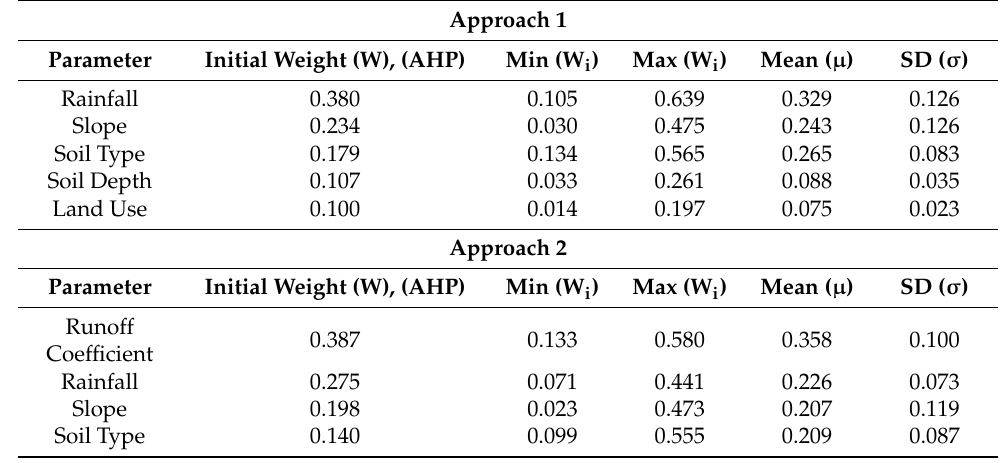
Figure 5. Potential RWH map of the study area for the first and second approaches after sensitivity analyses. Table 5. Statistics of the effective weights from sensitivity analysis.